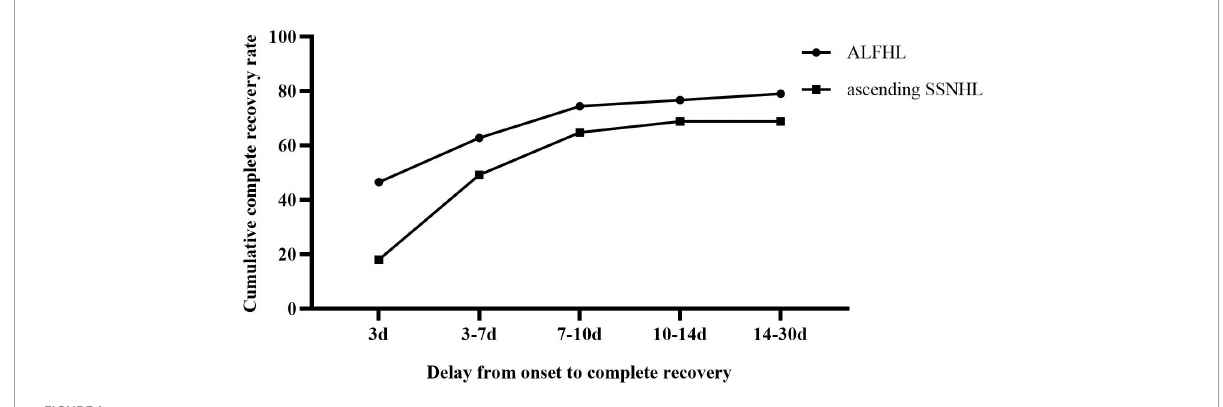
FIGURE1 Distribution of onset-CR of acute low-frequency hearing loss (ALFHL) and ascending sudden sensorineural hearing loss (SSNHL).